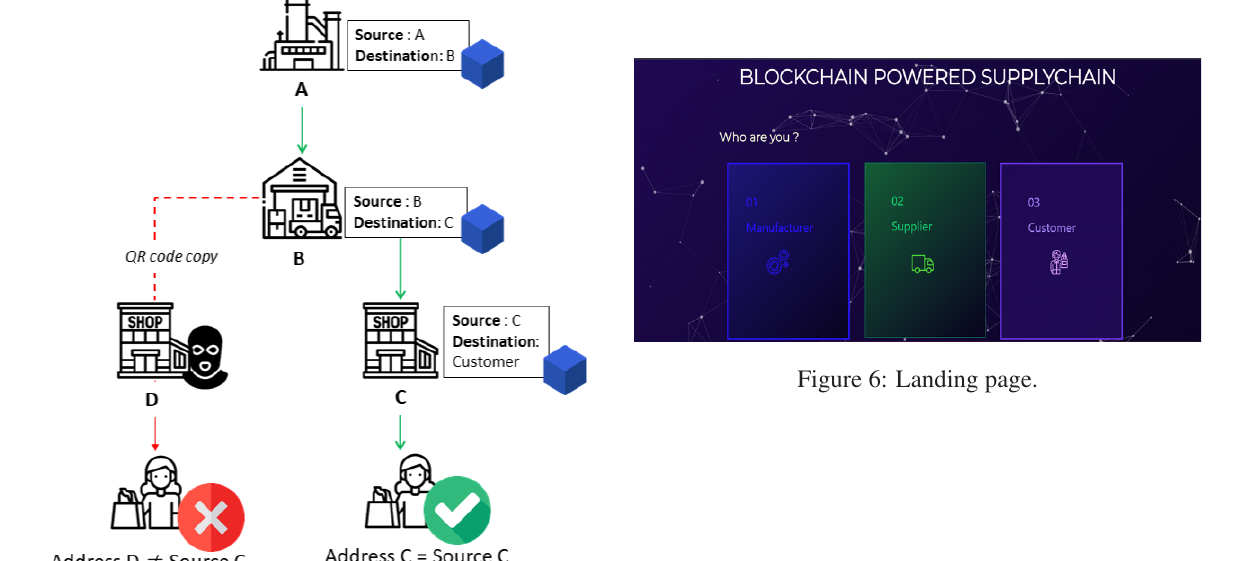
Figure 6: Landing page.